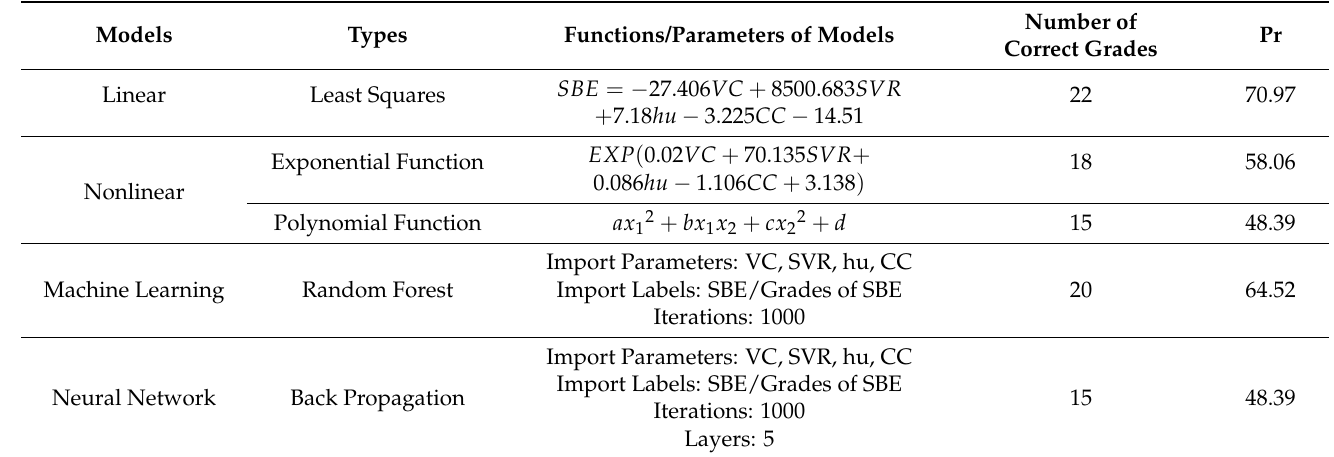
Table 3. Model parameter calculation and model establishment.